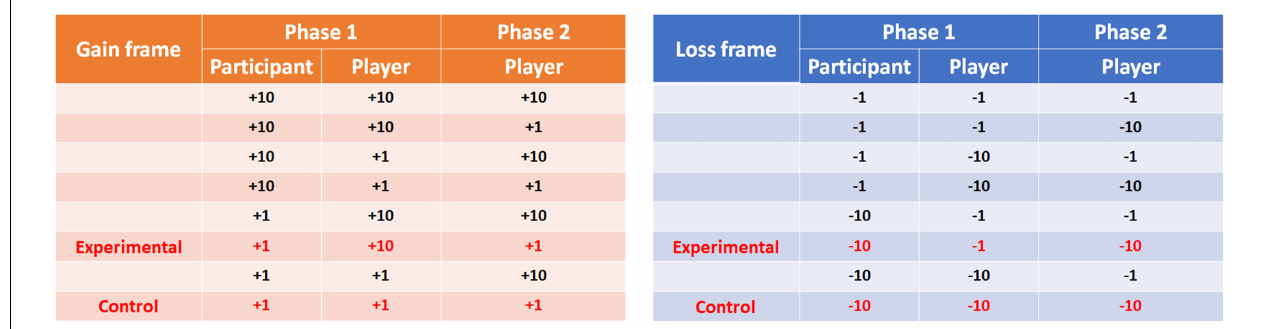
FIGURE 2 | The outcomes between the participants and the players for the two phases of the game in gain and loss frames (on the left and right panels, respectively). The outcomes in red are those in the experimental and control conditions. Phase 1 elicited envy and non-envy emotions, and Phase 2 assessed the feelings of pleasure